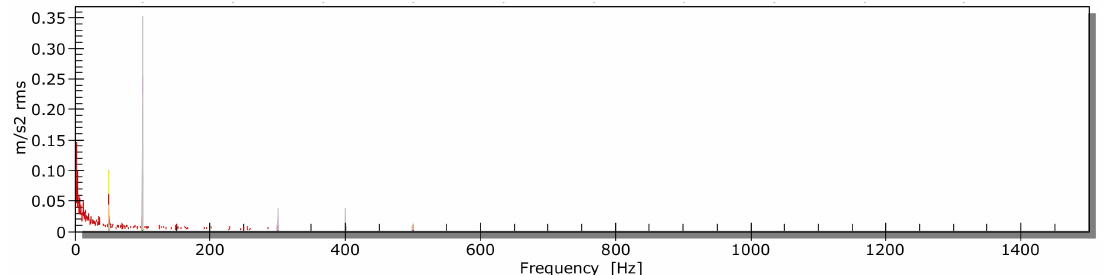
Figure 21. Spectrum analysis of z-direction vibration for coil (phase C).